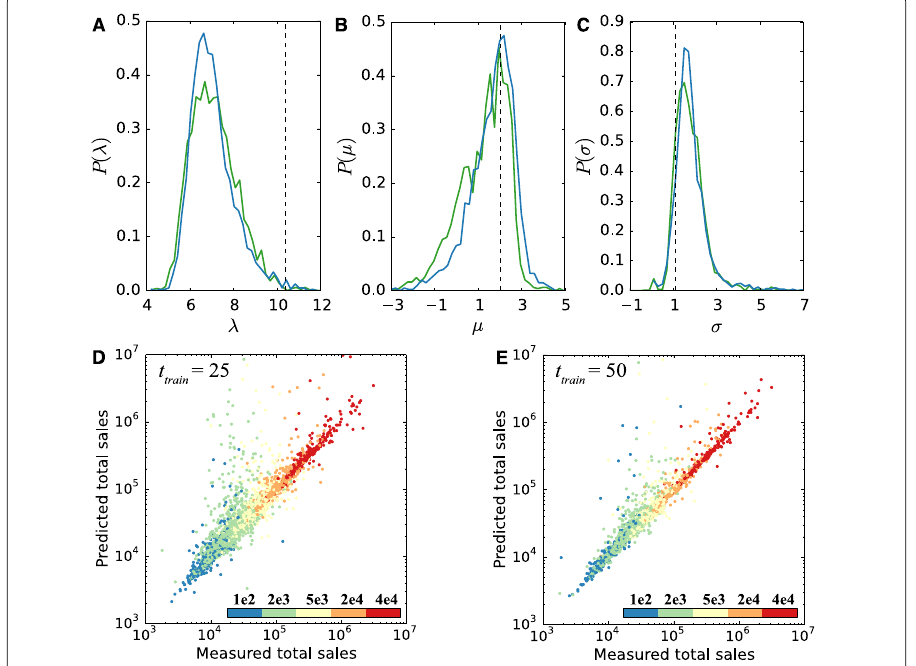
Figure 11 Predictingsales . Distribution of the parameters ( A ) fitness λ , ( B ) immediacy μ and ( C ) decay rate σ for all bestsellers, with fiction shown in green and nonfiction in blue. The dashed lines indicate the λ , μ and σ values of TheAppeal , indicating high fitness resulting in a higher total sales, average immediacy indicating typical peak sales time and slightly lower than typical decay rate meaning a relatively slow drop in sales after the peak. Predicted vs measured total sales calculated from Eq. (6), using the first ( D ) 25 and ( E ) 50 weeks to obtain λ . The colors represent the peak sale number for each book. The first 6 months offers an accurate picture for the full total sales and the prediction accuracy increases as longer times are used to calculate the fit. Additionally, total sales of books with higher peak sales are predicted better than of those with lower